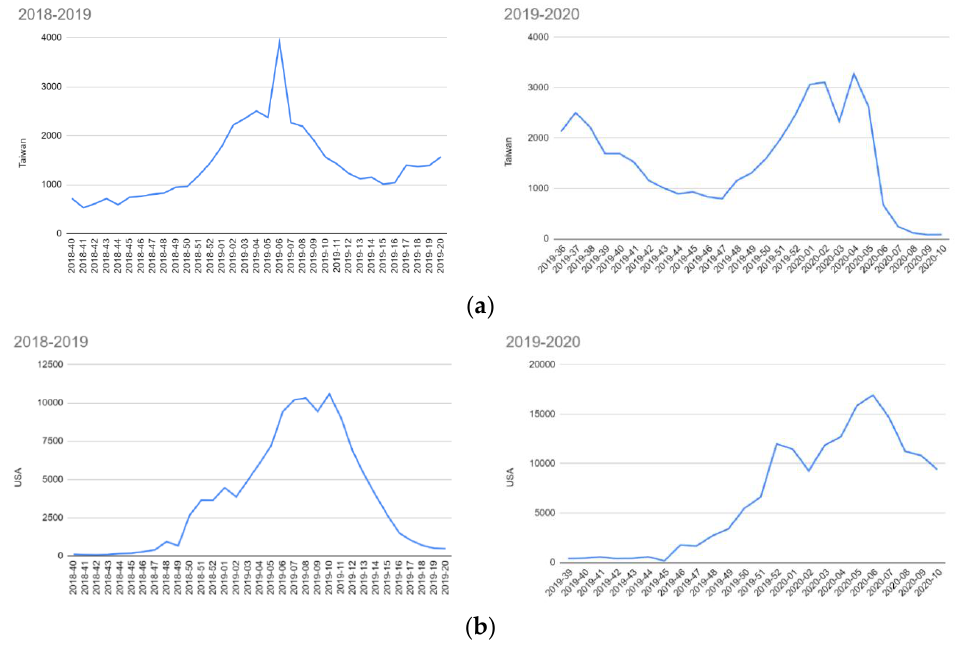
Figure 1. ( a ) Data extracted from Taiwanese Centers for Disease Control (Taiwan CDC) [6]. ( b ) Data extracted from American Centers for Disease Control and Prevention (US, CDC) [7]. Note: The figure shows the weekly records of confirmed influenzas A + B cases from 2018 to 2020: a comparison of cases in the US and Taiwan. x -axis: Year-Week interval & y -AXIS: number of